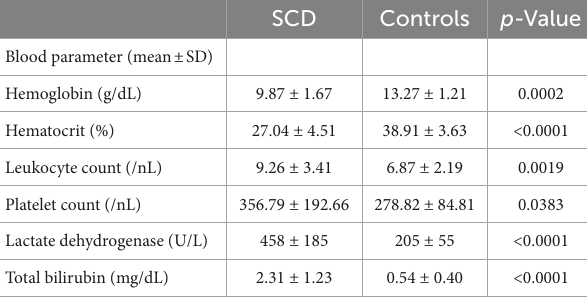
Results expressed as median and standard